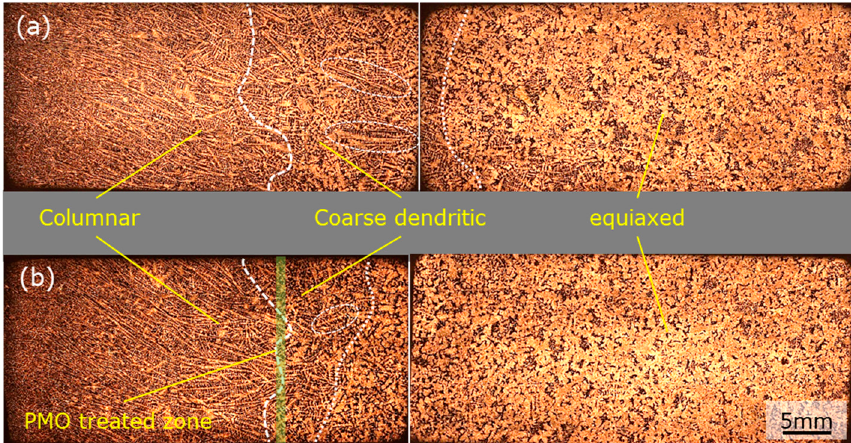
Figure 4. Microstructure in radial direction of No. 11 billet sample ( a ) without PMO and ( b ) with PMO.